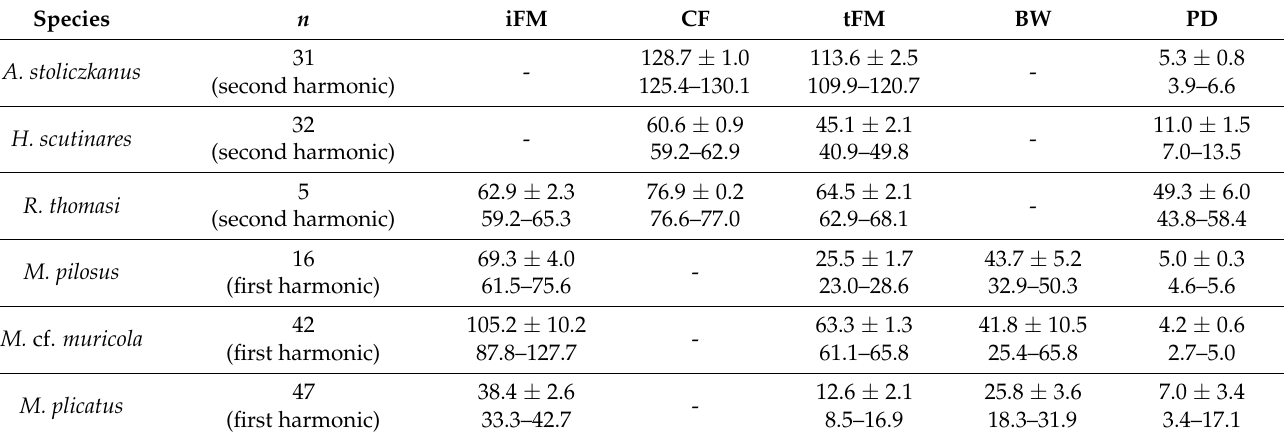
Table 2. Sound parameters of echolocating bat species from Ha Long Bay and Ben Tre province. Sample sizes are the numbers of signals measured within 5000 selected millisecond recordings for each species. Data are presented as range (minimum and maximum), mean and standard